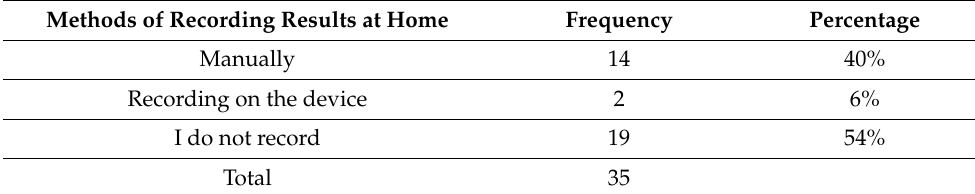
Table 4. Measurements recording methods employed at home.